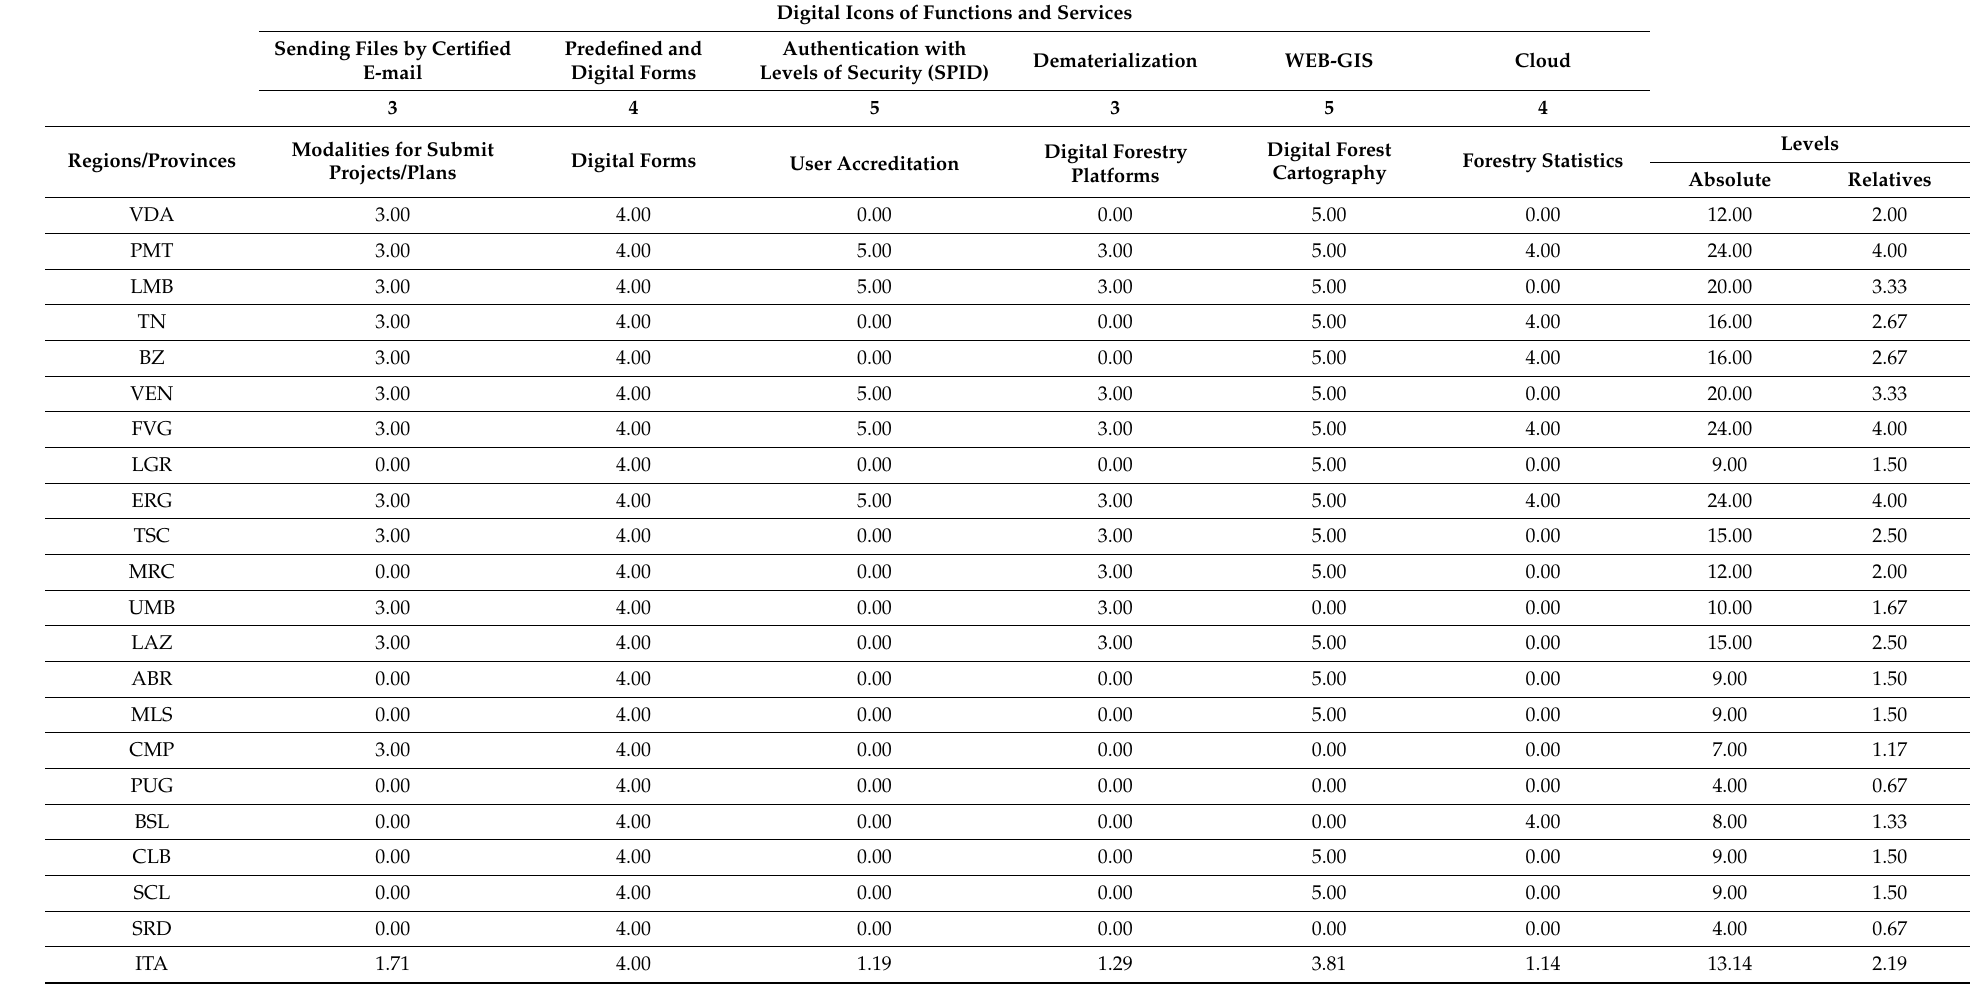
Table 5. Levels of digitisation in the Regions, Autonomous Provinces and